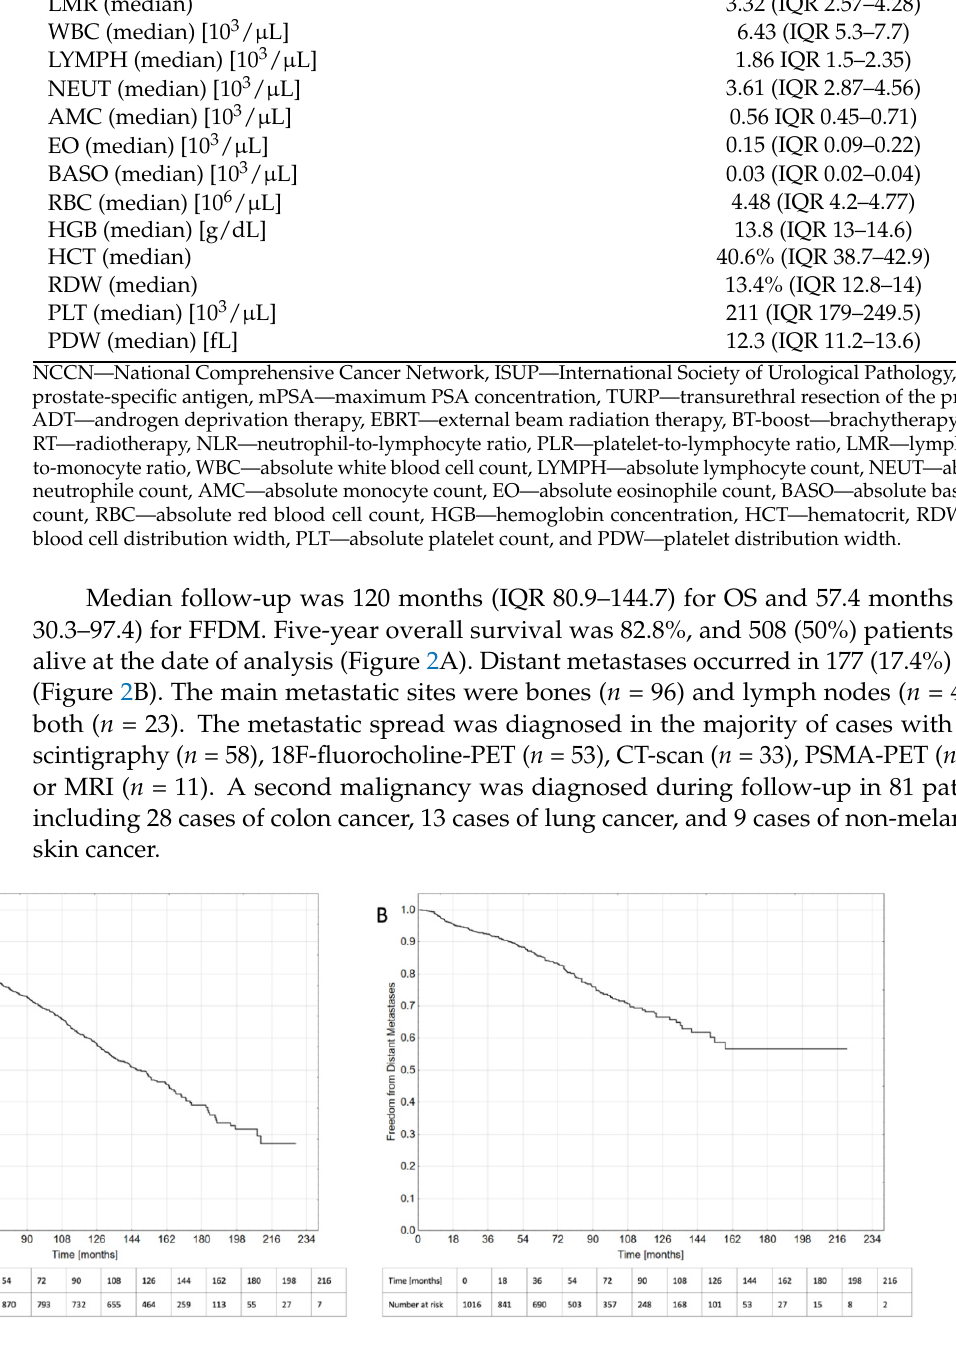
Figure 2. Overall survival (A) and freedom from distant metastases (B) in patients treated with radiotherapy for localized or locally advanced prostate cancer.